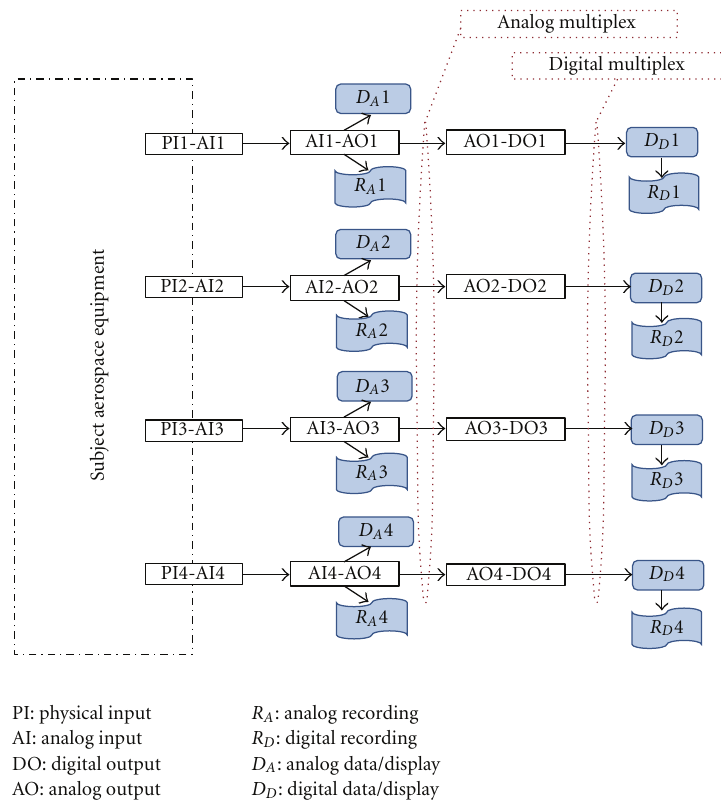
Figure 2: Generic functional architecture for DHM